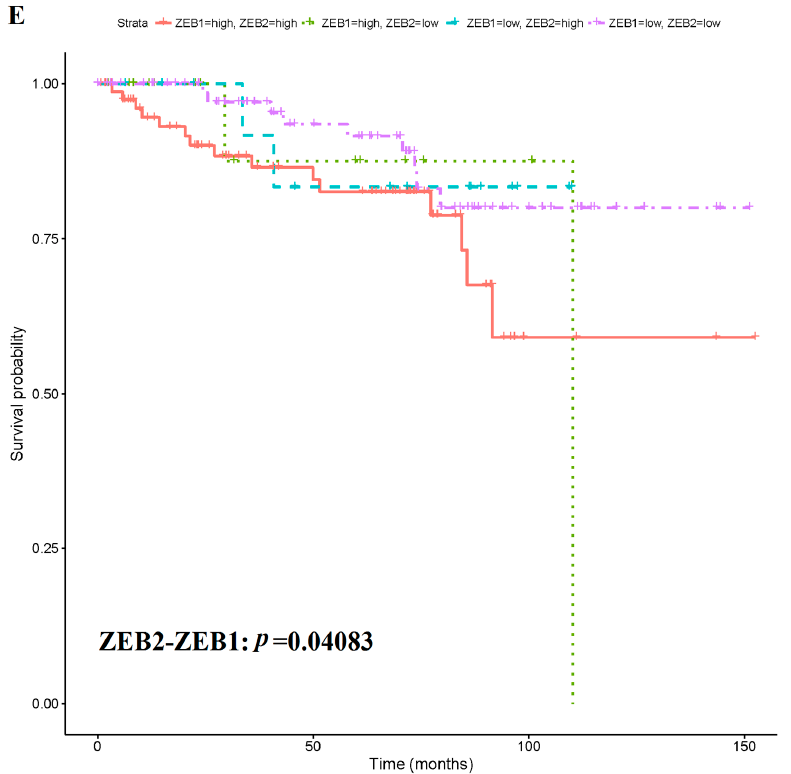
Figure 8. Kaplan-Meier survival curves of five multiple biomarkers with significant prognosis value. ( A ) Kaplan-Meier survival curves of multiple biomarker combined by PTEN and ZEB2. ( B ) Kaplan-Meier survival curves of multiple biomarker combined by STAT3 and S1PR1. ( C ) Kaplan-Meier survival curves of multiple biomarker combined by CASK and EPAS1. ( D ) Kaplan-Meier survival curves of multiple biomarker combined by KRAS, PTEN, STAT3, CD44, ZEB1, ZEB2 and S1PR1. ( E ) Kaplan-Meier survival curves of multiple biomarker combined by ZEB2 and ZEB1.